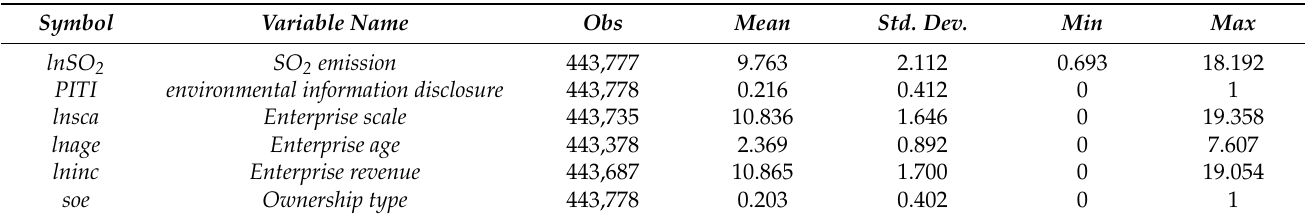
Table 1. Variable descriptive